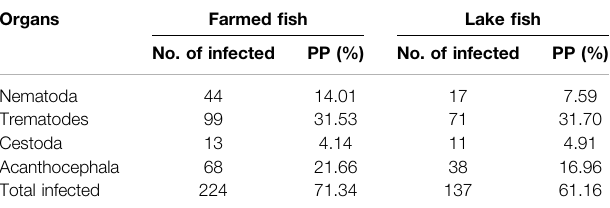
TABLE 4| Prevalenceofdifferentparasites species(PP)amongtheexamined fi sh O. niloticus, collected from Fish Farm and Burullus Lake. Organs Farmed fi sh Lake fi sh No. of infected PP (%) No. of infected